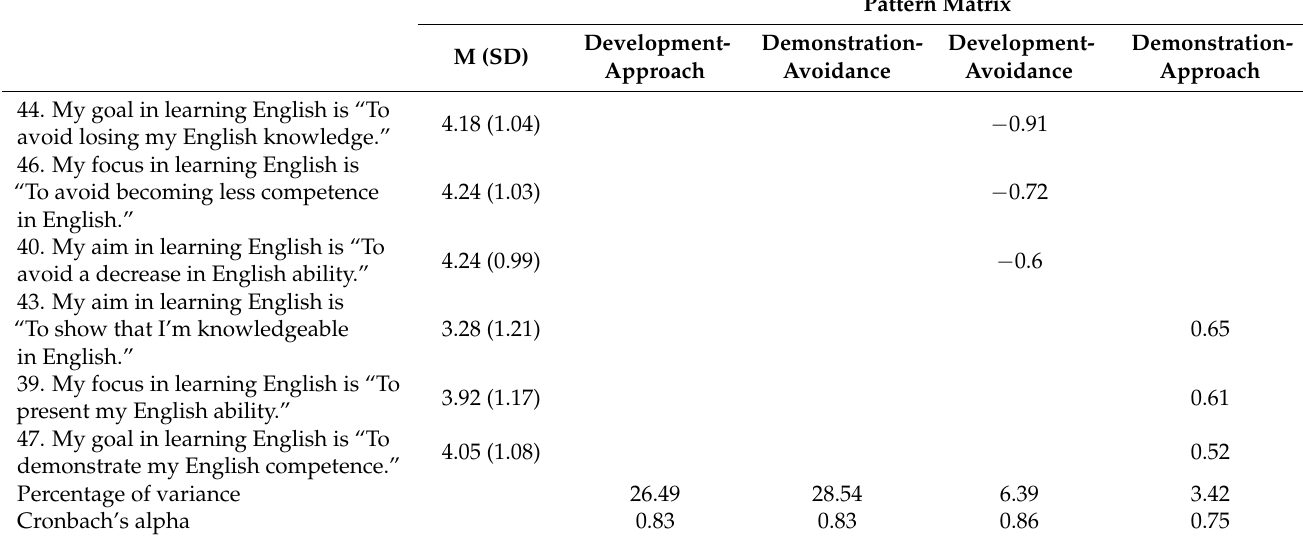
Table A2. Cont. M (SD)